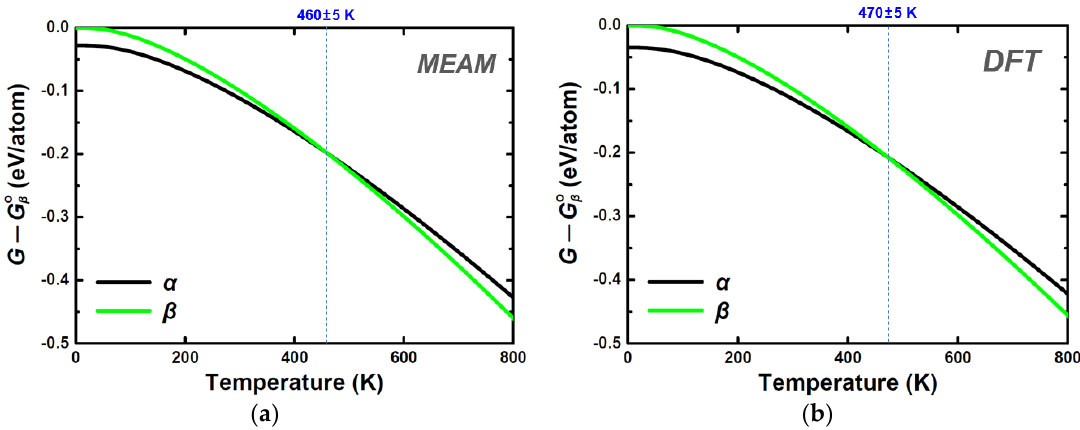
Figure 6. Relative Gibbs free energies of α and β phases at various temperatures, calculated based on the quasiharmonic approximation (QHA). The results using ( a ) the present 2NN MEAM and ( b ) the present DFT calculation are illustrated. Each energy value was calculated with respect to the reference state of the β phase at 0